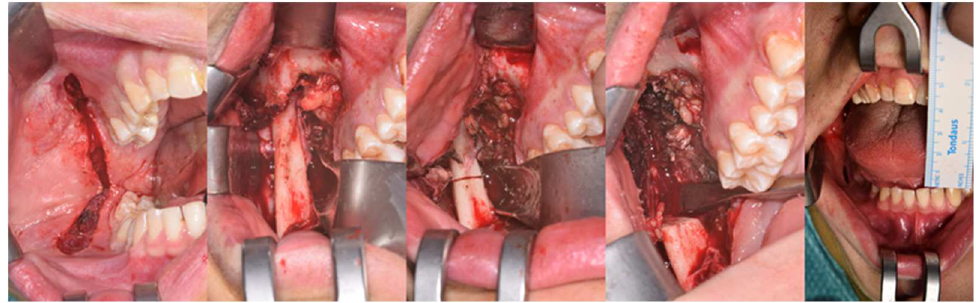
Figure 8. Surgical sequence of the intraoral coronoidectomy. The patient shows an immediate improvement in the MMO up to 40 mm.